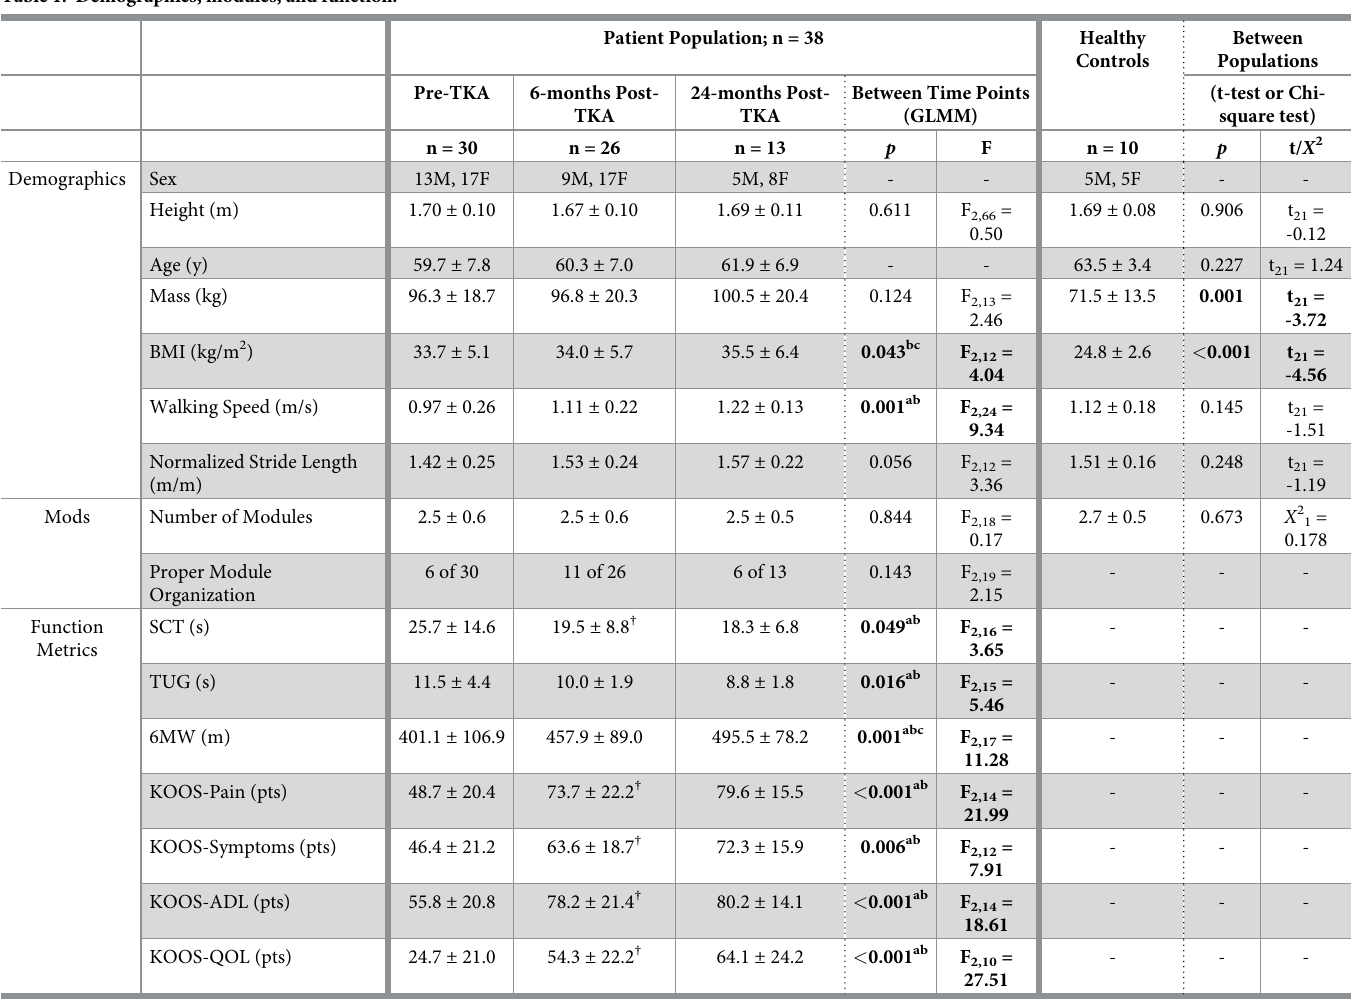
Table 1. Demographics, modules, and function.